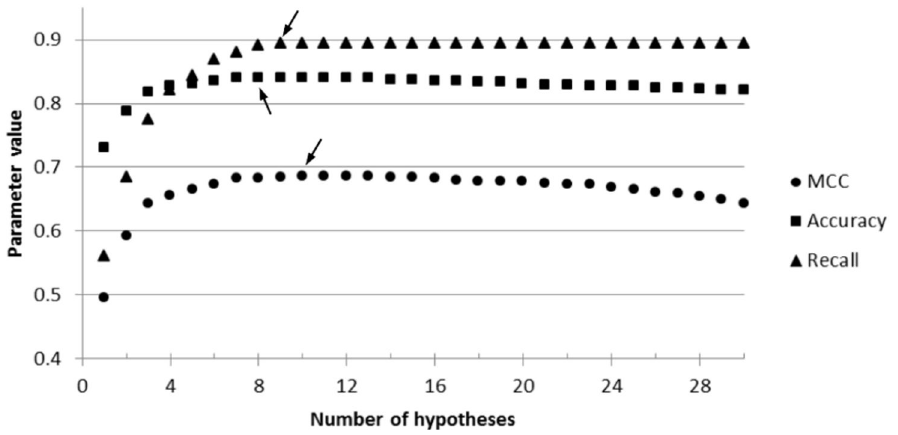
Figure 8. An optimization curve for the investigated parameters of a top-ranked linear combination of MCC (M2D/random/hit-once); arrows indicate the maximum value: MCC reached a rate of 0.686 for 10 hypotheses (also see Figure 6); the optimization of accuracy and recall had the highest values for a combination of 8 and 9 hypotheses, respectively (also see Figures S1 and